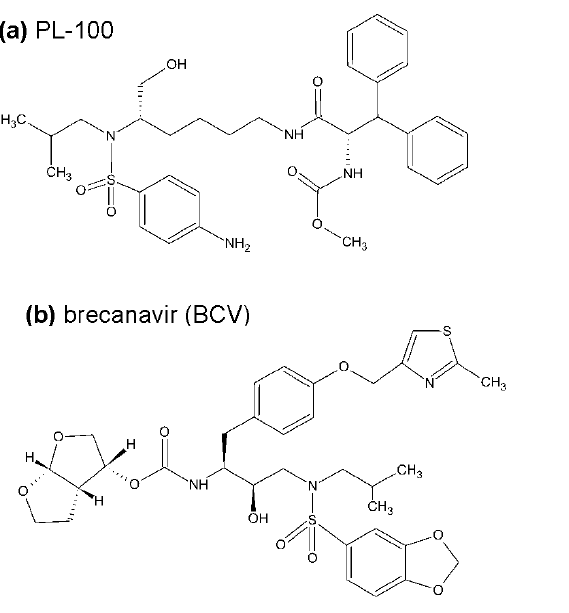
Figure 5. Chemical structures of inhibitors HIV protease in the